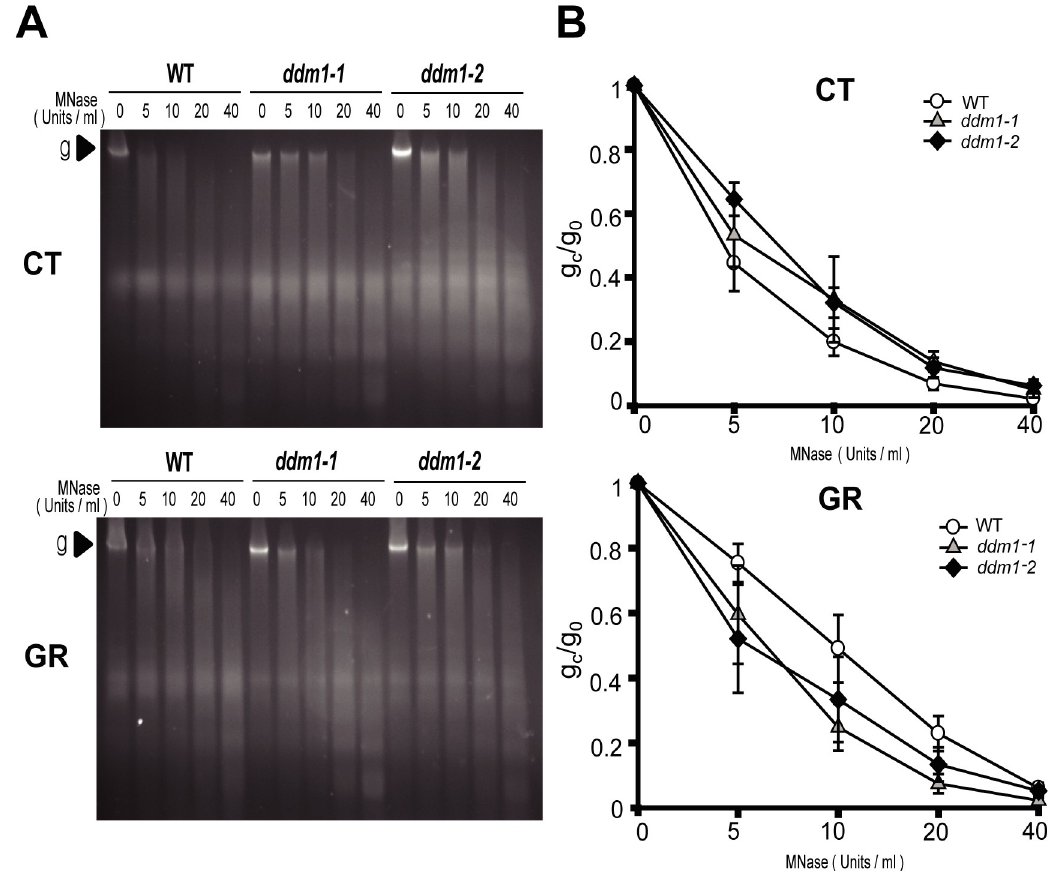
Fig 6. DDM1 mutation affects chromatin structure before and after gamma irradiation. (A) Chromatin digestion with micrococcal nuclease (MNase). (B) Proportion of MNase-digested chromatin DNA resolved on agarose gels. The genomic band intensities without (g 0 ) and with (g c ) treatment with different concentrations of MNase were quantified, and the ratio of g c /g 0 was used to represent the degree of chromatin relaxation. Bars represent means ± SE (n = 3) of three independent experiments. CT, control; GR, gamma